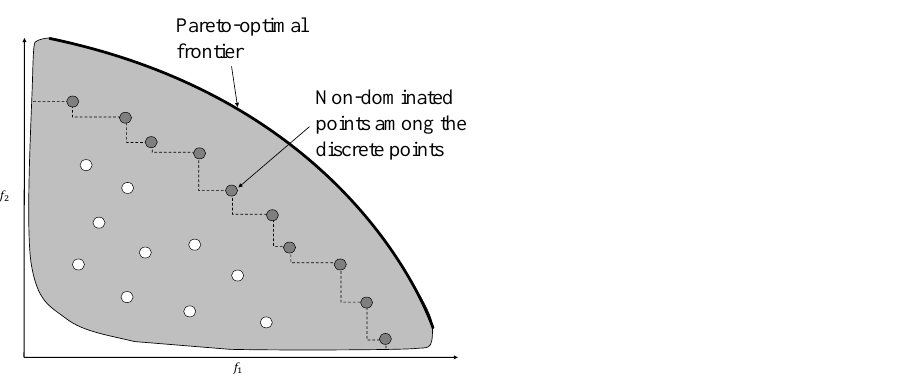
Figure 2. Non-dominated set from a discrete set of points and a Pareto-optimal front that dominates the entire search